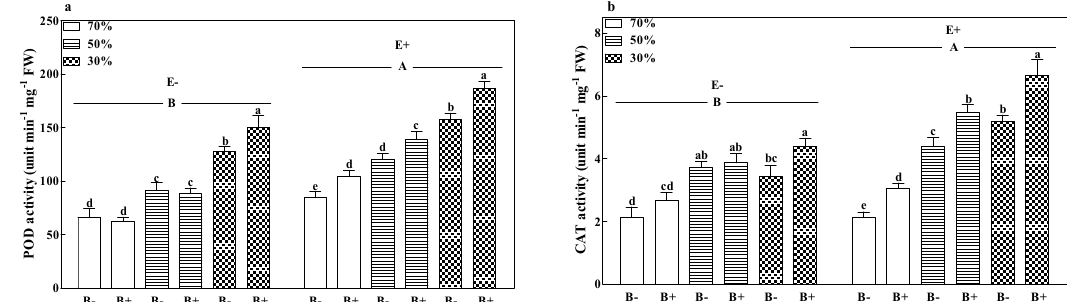
Figure 5. Peroxidase (POD) ( a ) and catalase (CAT) ( b ) enzyme activity of perennial ryegrass infected with (E+) or without (E − ) fungal endophyte and inoculated (B+) or noninoculated (B − ) with pathogen at 70%, 50%, and 30% soil water regimes at harvest. Mean ± SEM of four replicates are shown. Bars topped by the same lowercase letter indicate no significant difference between soil water regimes and pathogen within fungal endophyte treatments at p ≤ 0.05 by Tukey’s HSD test. Bars topped by the same uppercase letter indicate no significant difference associated with fungal endophyte at p ≤ 0.05 by Tukey’s HSD test.